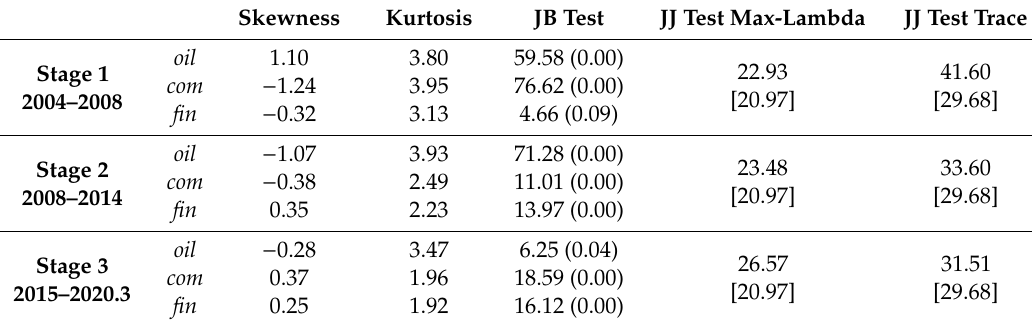
Table 3. Tests of variables in di ff erent sample intervals.